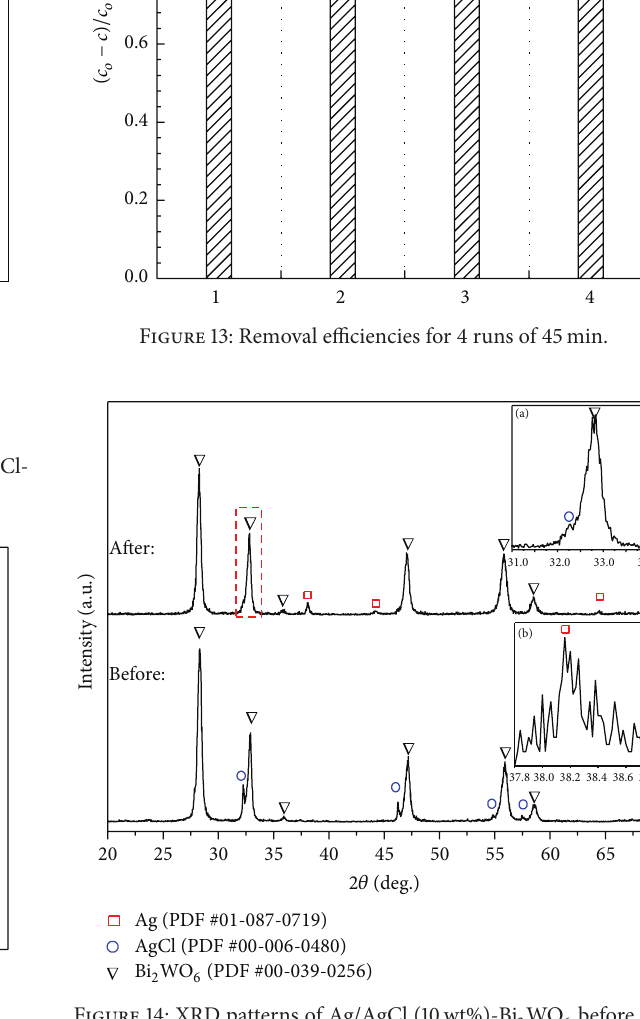
Figure 14: XRD patterns of Ag/AgCl (10wt%)-Bi 2 WO 6 before and after 4